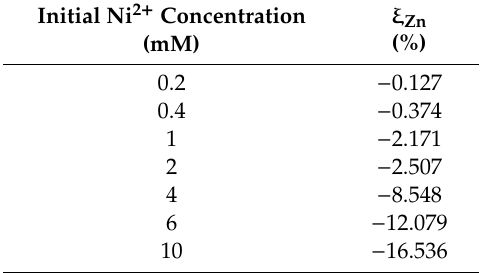
Table 3. The global index of behavior for Zn 2 + biosorption ( ξ Zn ) at di ff erent initial Ni 2 + concentrations. Initial Ni 2 +